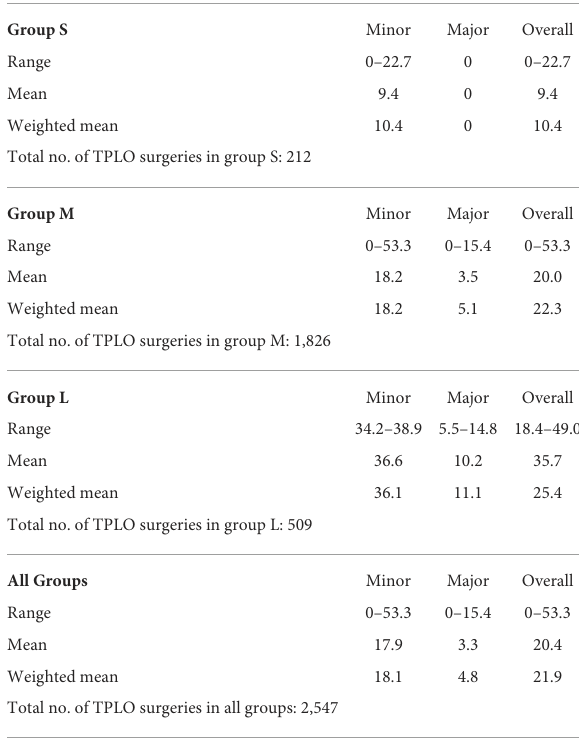
TABLE 5 Complication rates in percent for